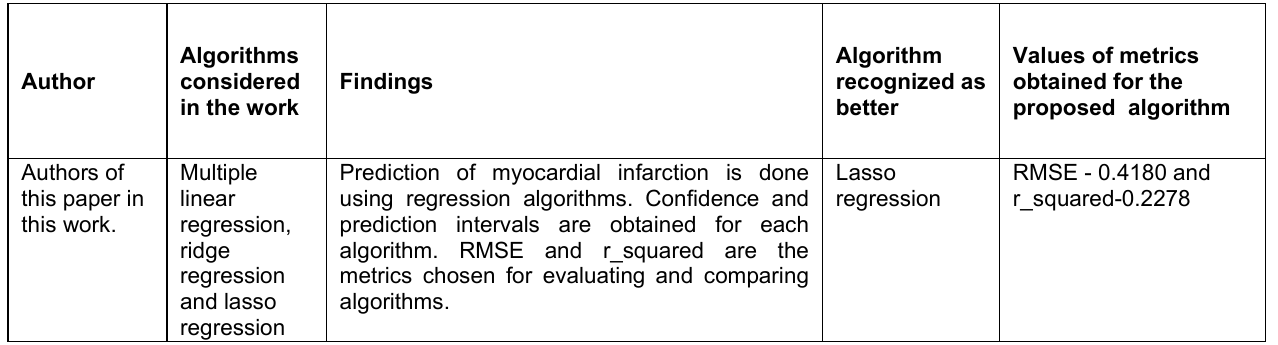
Table 4. Comparing literature work with proposed